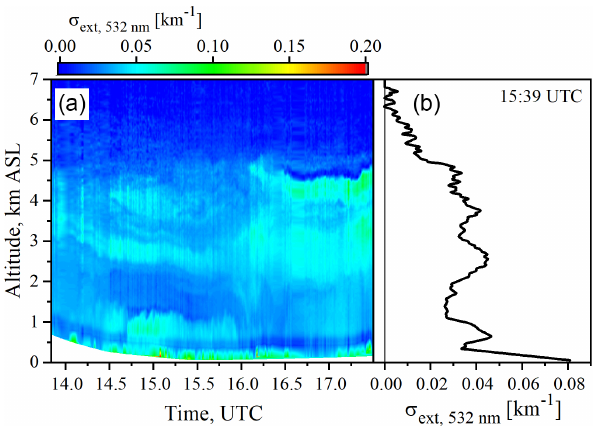
Figure 13. (a) Spatio-temporal variability of extinction coefficient derived from the joint inversion of in situ and remote sensing data and (b) example of extinction profile along the mobile tran- sect at 15:36UTC. The illustrated example corresponds to mo- bile measurements performed on 7 July 2017 from Saint-Michel l’Observatoire (43.93 ◦ N, 5.71 ◦ E) to Valence (45.25 ◦ N, 4.83 ◦ E),